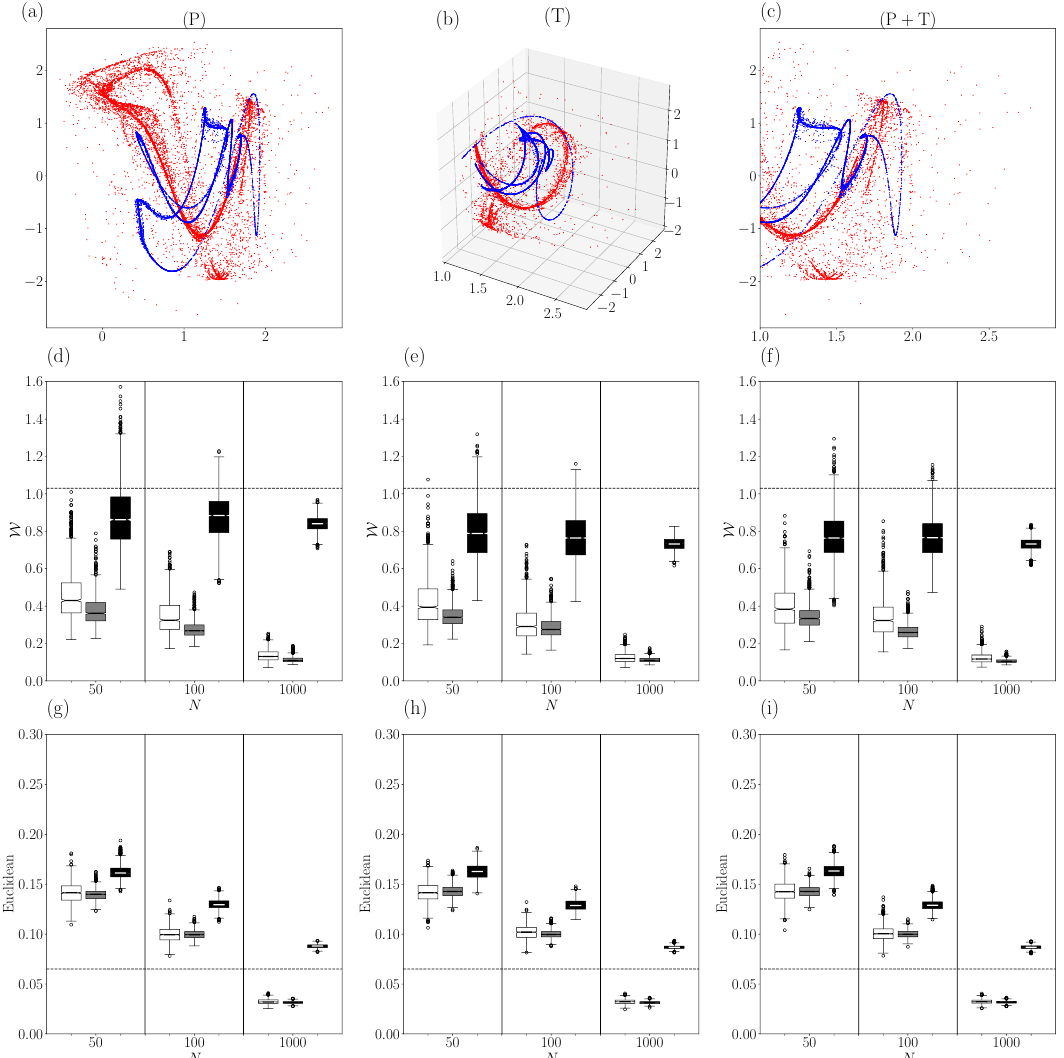
1 of the winter and ≥ P ) in Sect. 3.4). (d–f) box plots of distances between design T , P and + P computed with the Euclidean +